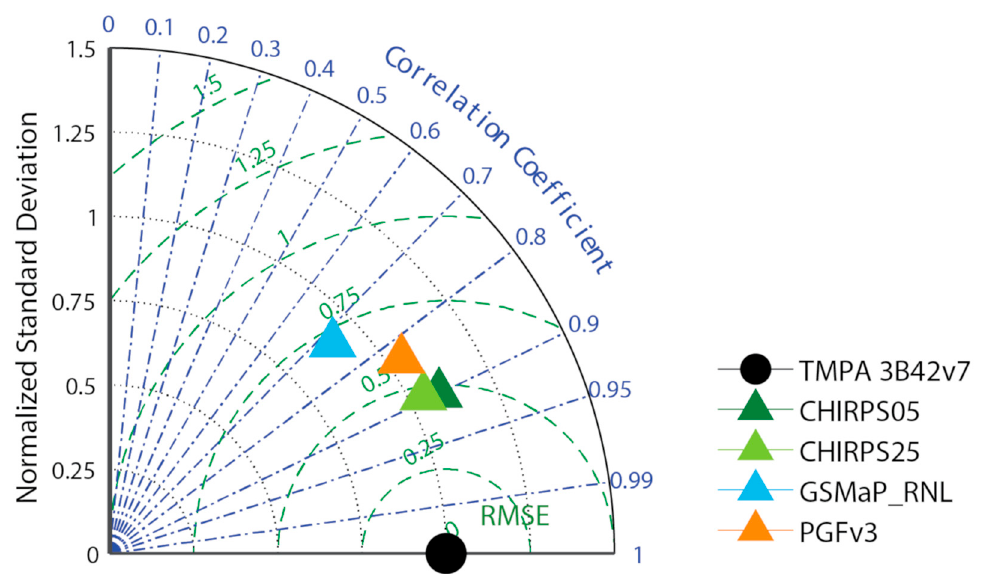
Figure 13. Taylor diagram of all gridded rainfall products using TMPA 3B42v7 as a reference dataset.